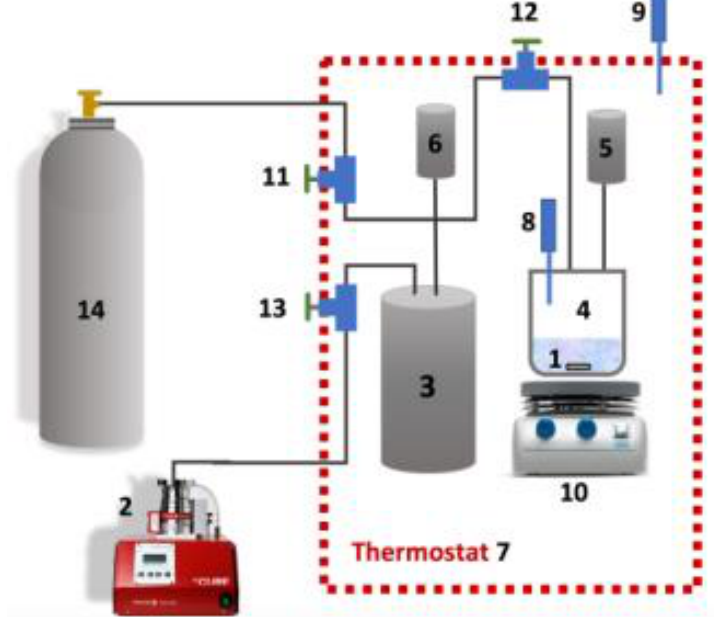
Figure 1. Scheme of the experimental setup: 1 — sample; 2 — vacuum pump; 3 — gas container; 4 — high-pressure equilibrium cell; 6 — pressure sensor; 7 — thermostatic air bath; 8, 9 — temperature sensor; 10 — magnetic stirrer; 11 — 13 — valves; 14 — gas cylinder.